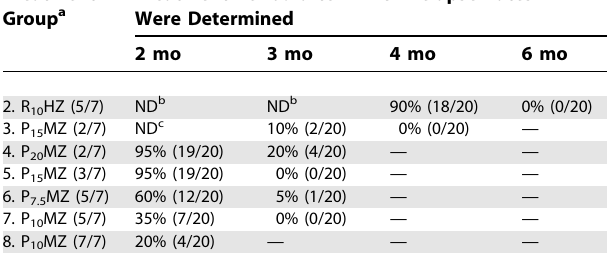
Table 2. Culture-Positive Relapse Rates after Treatment with the Standard Daily Regimen (RHZ) and with Intermittent and Daily PMZ Regimens in M. tuberculosis –Infected Mice